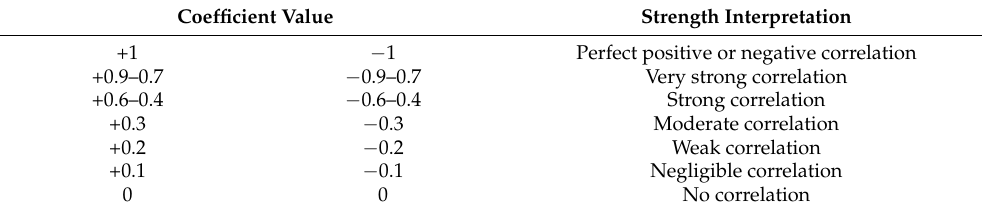
Table 1. Criteria applied for the strength interpretation of Spearman’s rank correlation coefficient.